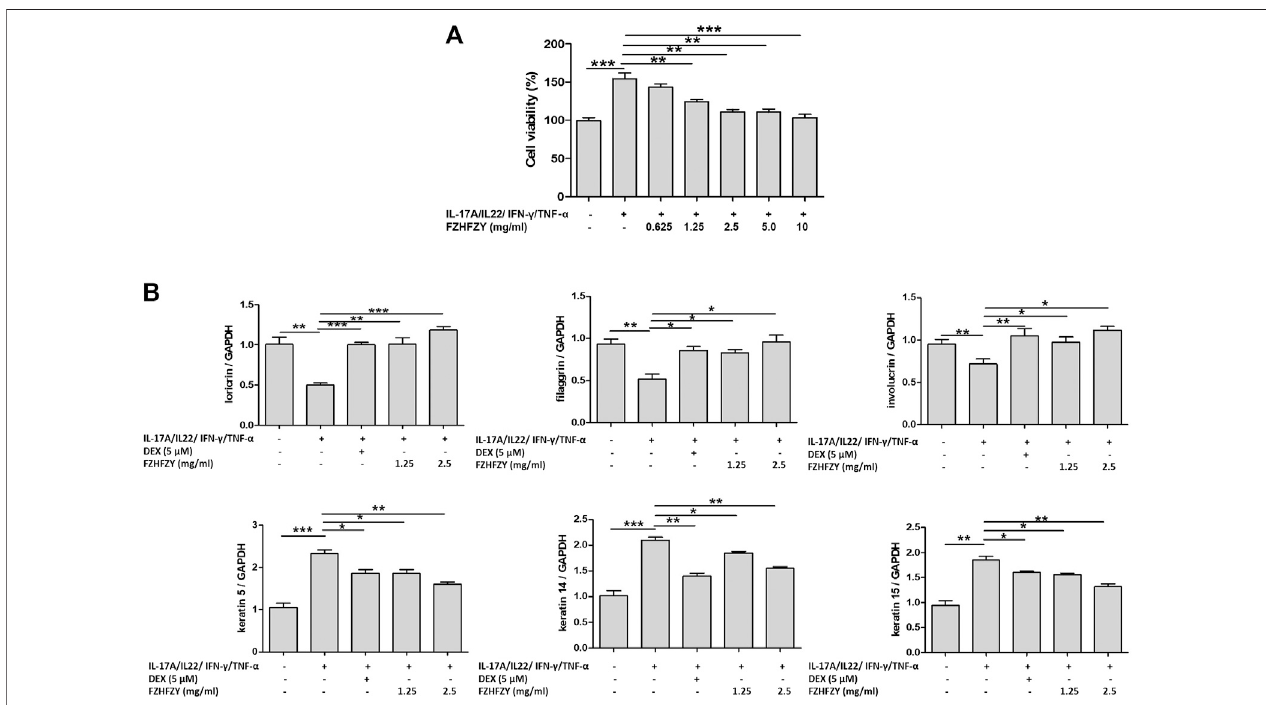
FIGURE 2 | FZHFZY inhibits proliferation and improves epidermal differentiation of interleukin (IL)-17A/IL-22/interferon (IFN)- γ /tumour necrosis factor (TNF)- α – stimulated HaCaT cells. (A) HaCaT cells were treated with IL-17A (10 ng/ml), IL-22 (10 ng/ml), IFN- γ (10 ng/ml) and TNF- α (25 ng/ml) for 24 h, then various concentrations of FZHFZY from 0.625 to 10 mg/ml were added to the wells, followed by another 24-h incubation, and the effects of FZHFZY on cell viability was measured via MTT assay. (B) IL-17A/IL-22/IFN- γ /TNF- α – stimulated HaCaT cells were treated with 1.25 or 2.5 mg/ml FZHFZY for 24 h. Total RNA was isolated from HaCaT cells, and RT-PCR was used to investigate the mRNA levels of various molecules of epidermal differentiation.